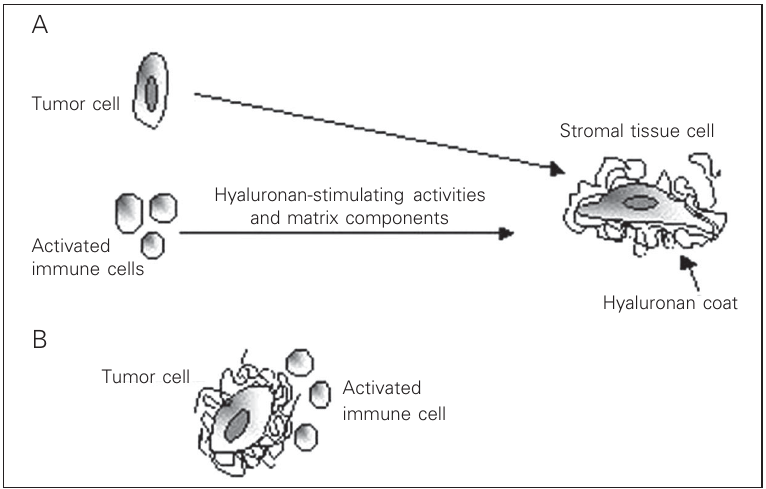
Figure 1. Hyaluronan synthesis during tumor progression. A host tumor stromal cell is surrounded by a hyaluronan-containing coat in response to hyaluronan-stimulating activities and matrix components secreted by a tumor cell and/or activated immune cells (A). A tumor cell surrounded by a hyaluronan-containing coat excludes host immune cells